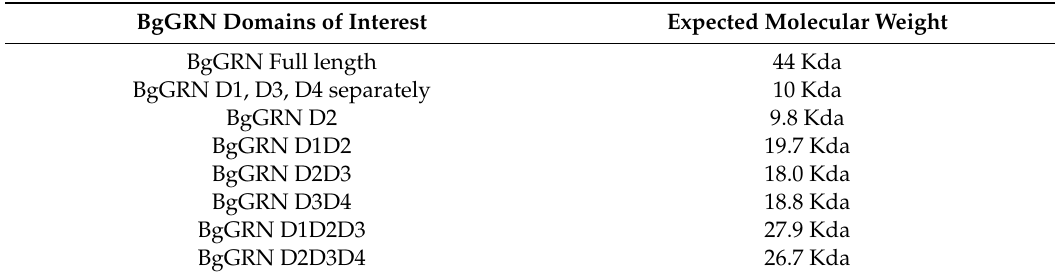
Table 2. Predicted sizes of full-length BgGRN, its 2 and 3 granulin domain-containing intermediates, as well as the individual granulin